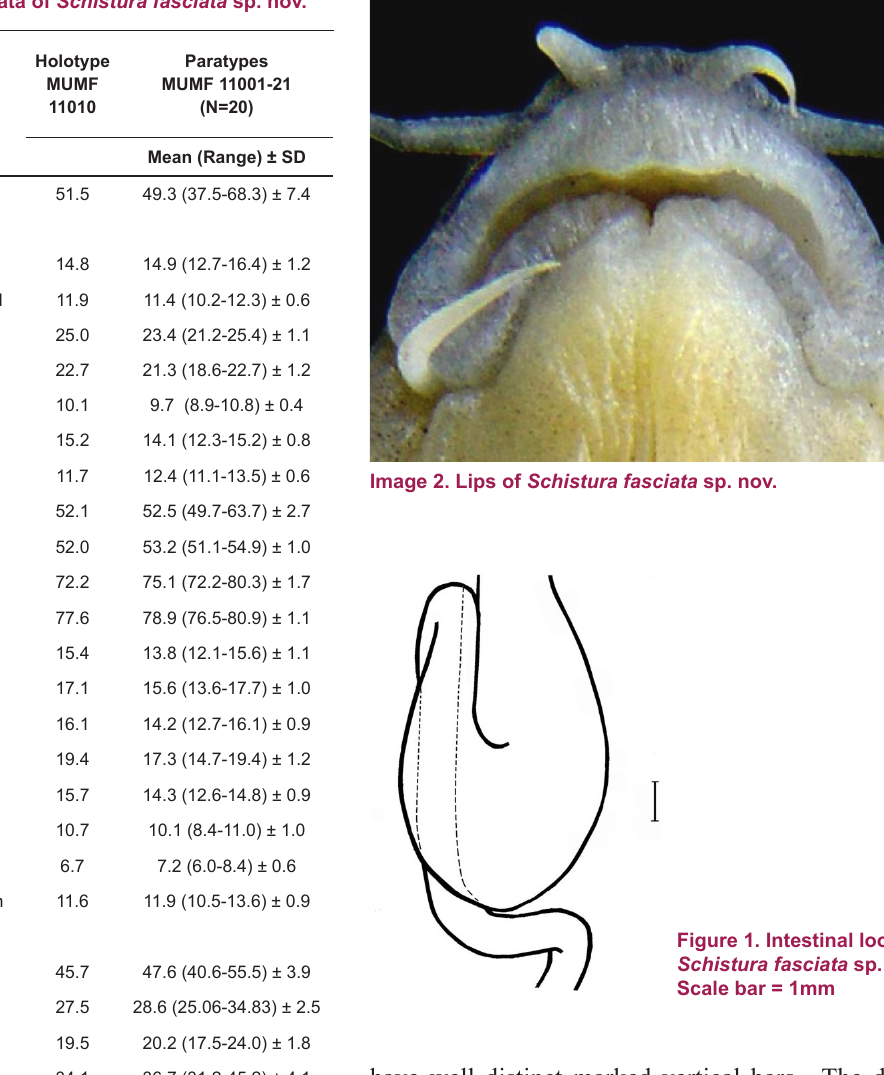
have well distinct marked vertical bars. The dorsal surface of males is straight horizontally and with a well develop prominent dorsal adipose crest. The anterior dorsal profile of females are well arched and the adipose dorsal crest not prominent as in male. colouration: In live, body faintly golden to grey with 11 to 13 olivaceous dark brown vertical bars. Colour pattern and number of bars are more or less variable with a unique arrangement. 5-6 bars are on the pre-dorsal, 3 in dorsal and 4-5 bars on the post- dorsal. Bars on the pre-dorsal are broader than the posterior ones. They are united mid-dorsally and their inter-bands are wider towards the posterior. All the rays of the dorsal, ventral, pectoral and anal fins are with a row of faintly black elongated marks. A